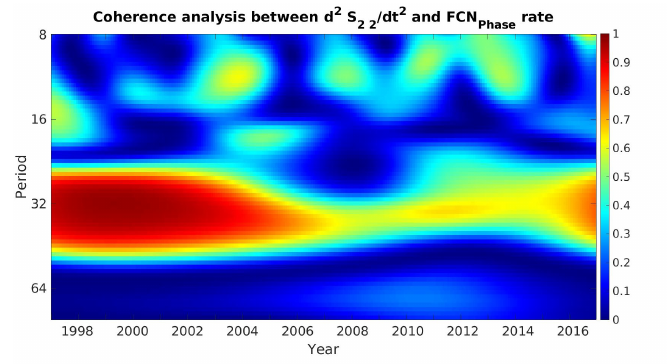
Figure 8. Wavelet coherence analysis between d 2 S 2”